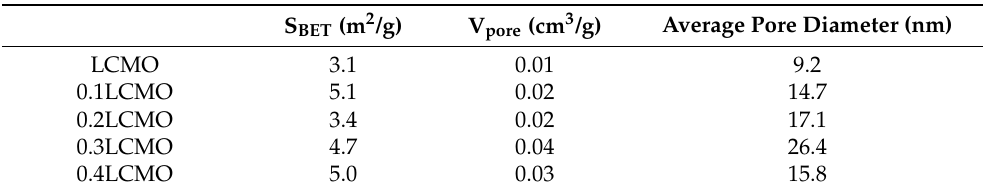
Table 2. Structural information of the fresh catalysts.